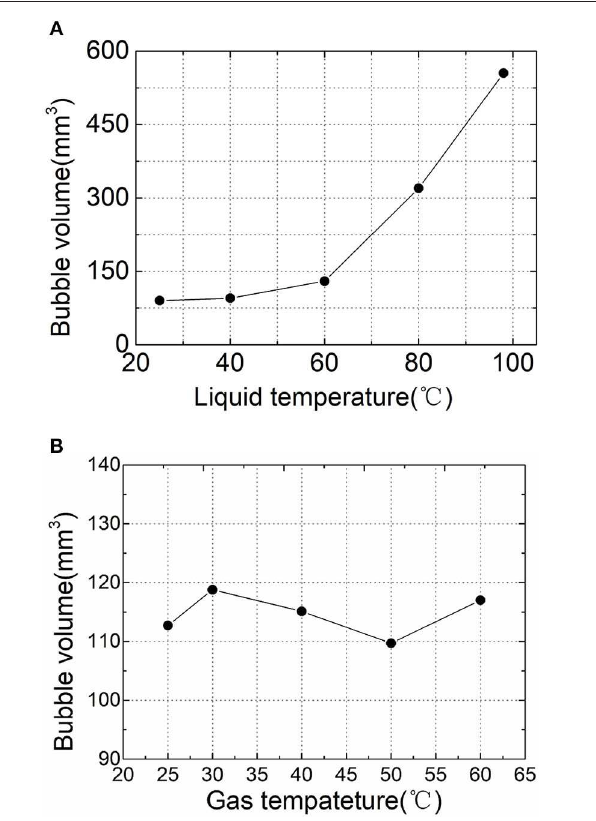
FIGURE 3 | Effect of gas and liquid temperature on bubble generation volume. (A) Effect of liquid temperature. (B) Effect of gas